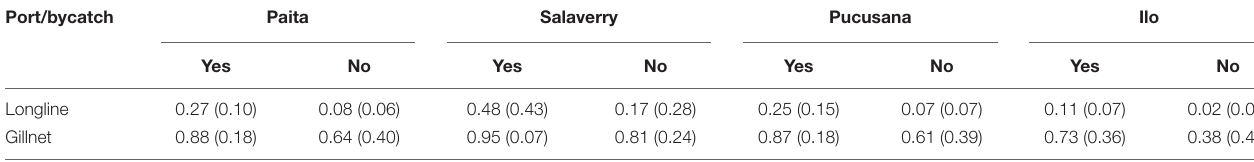
TABLE 4 | Summary results of in-depth interviews with longline and gillnet fishers ( n = 12) in Salaverry and Pucusana. Longline